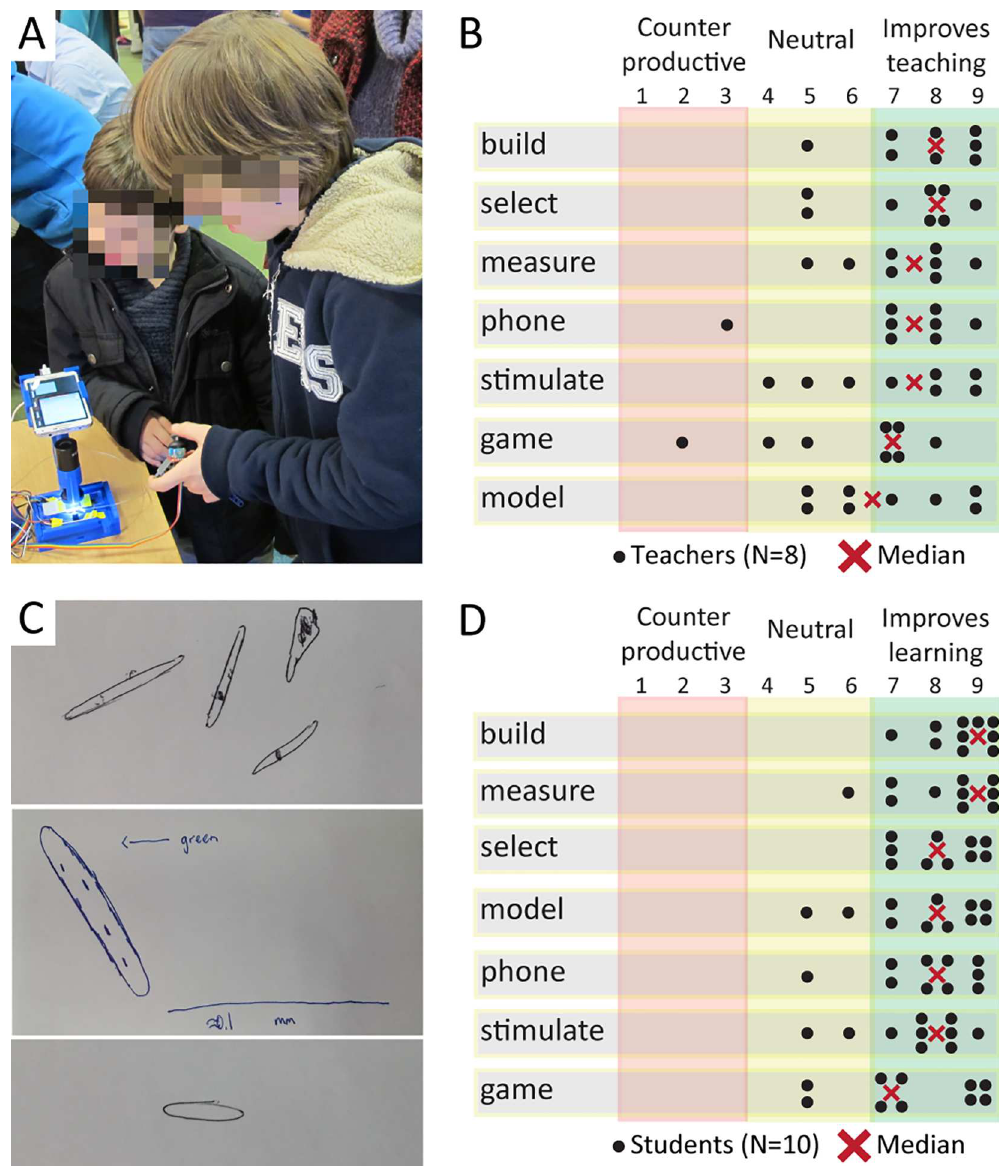
Fig 5. User studiesdemonstrate the potentialof the LudusScope for STEM education. ( A ) An example of a user study settingin which childreninteractwith the LudusScope.( B ) Teacher scoring(n = 8; Likertscale, 1–9) of seven potentialadvantages of the LudusScopeover currentlyexisting teachingpractices. Overall, these scores highlightthe utility of the LudusScope; the self-building and measurement features seemedmost desirable to these teachers.“Build”correspondsto the construction aspect of the LudusScope, “select”is ability to choose Euglena to follow, “measure”is abilityto make quantitative measurements, “phone” is the integrationof a smartphone, “stimulate” is the directionallight stimulusand phototaxisof Euglena ,“game”is the utilityof games for learning,and “model”is the utility of the Scratch model for learning.( C ) Examplesof studentdrawings of Euglena based on observations with the LudusScope. ( D ) Student scoring(n = 10; Likertscale, 1–9) of seven potential advantages of the LudusScopeover currentlyexisting teachingpractices. The categoriesare the same as in the teacher response. Overall, the studentsrate the platformhighly, and align well with the